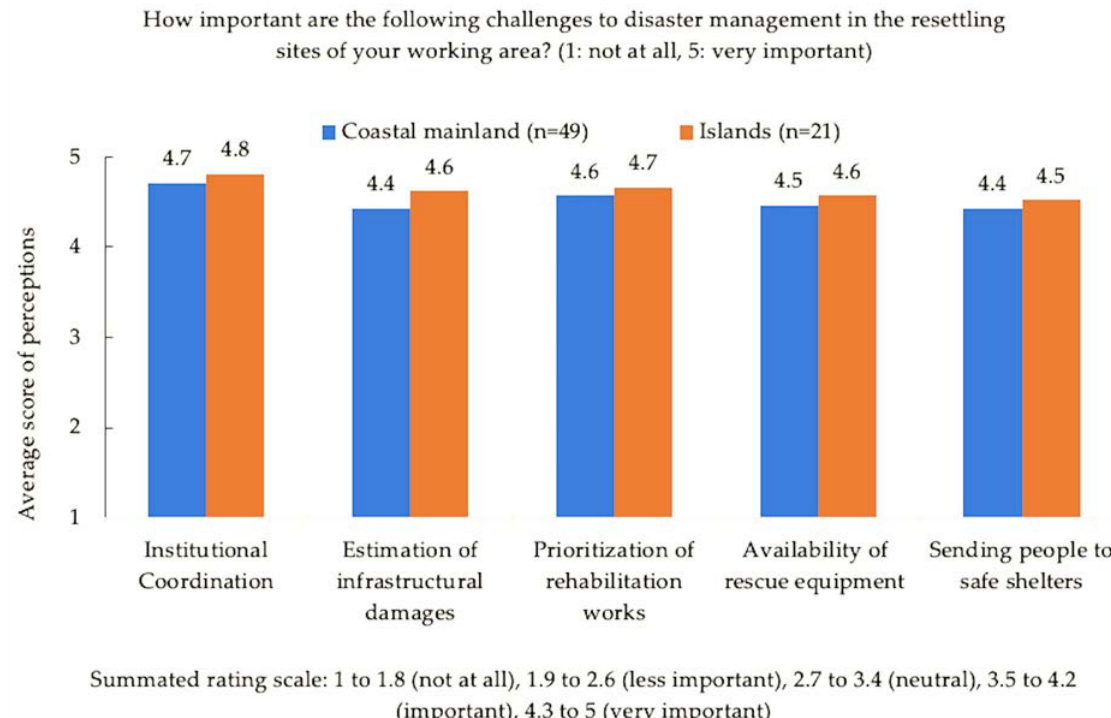
Figure 4. Perception on climatic disaster management